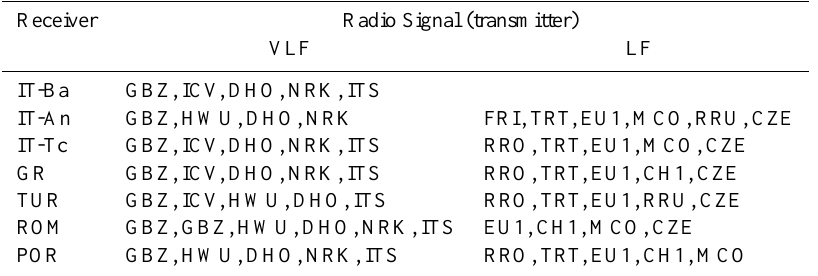
Table 1. List of the VLF/LF radio signals sampled by each receiver of the network. Receiver